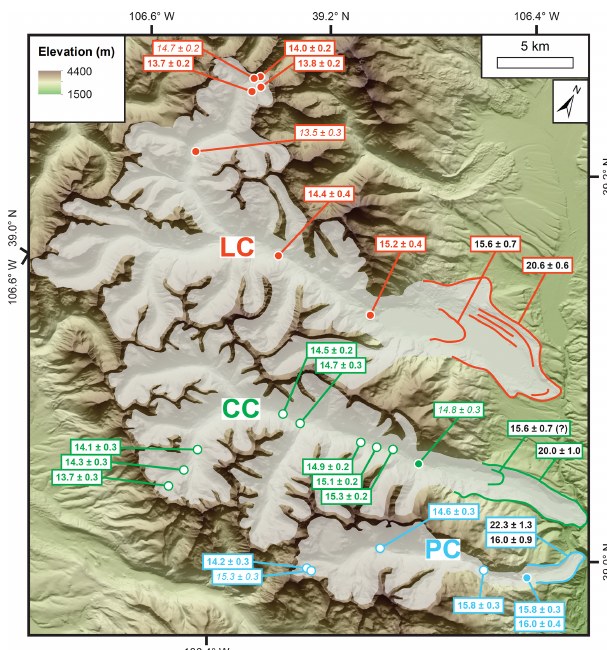
Figure 2. Ice-sculpted bedrock 10 Be ages from Lake Creek (LC; orange), Clear Creek (CC; green), and Pine Creek valleys (PC; blue). New ages are open circles and previously published ages are closed. Bedrock ages with italicized labels are suspected out- liers. Included are LGM and recessional moraines (solid colored lines and labels with black text) with reported ages for the LGM moraines in all three valleys, including the younger mode in Pine Creek valley at 16 . 0 ± 0 . 9ka ( n = 7; Young et al., 2011) and a recessional moraine in Lake Creek valley at 15 . 6 ± 0 . 7ka ( n = 5; Schweinsberg et al., 2020). There is a similar, undated recessional moraine in Clear Creek valley that we hypothesize is also ∼ 16ka. Ice-sculpted bedrock ages reported here include analytical uncer- tainty, and moraine ages are reported as the mean and 1 standard deviation. Glaciers at their mapped LGM extents are delineated in